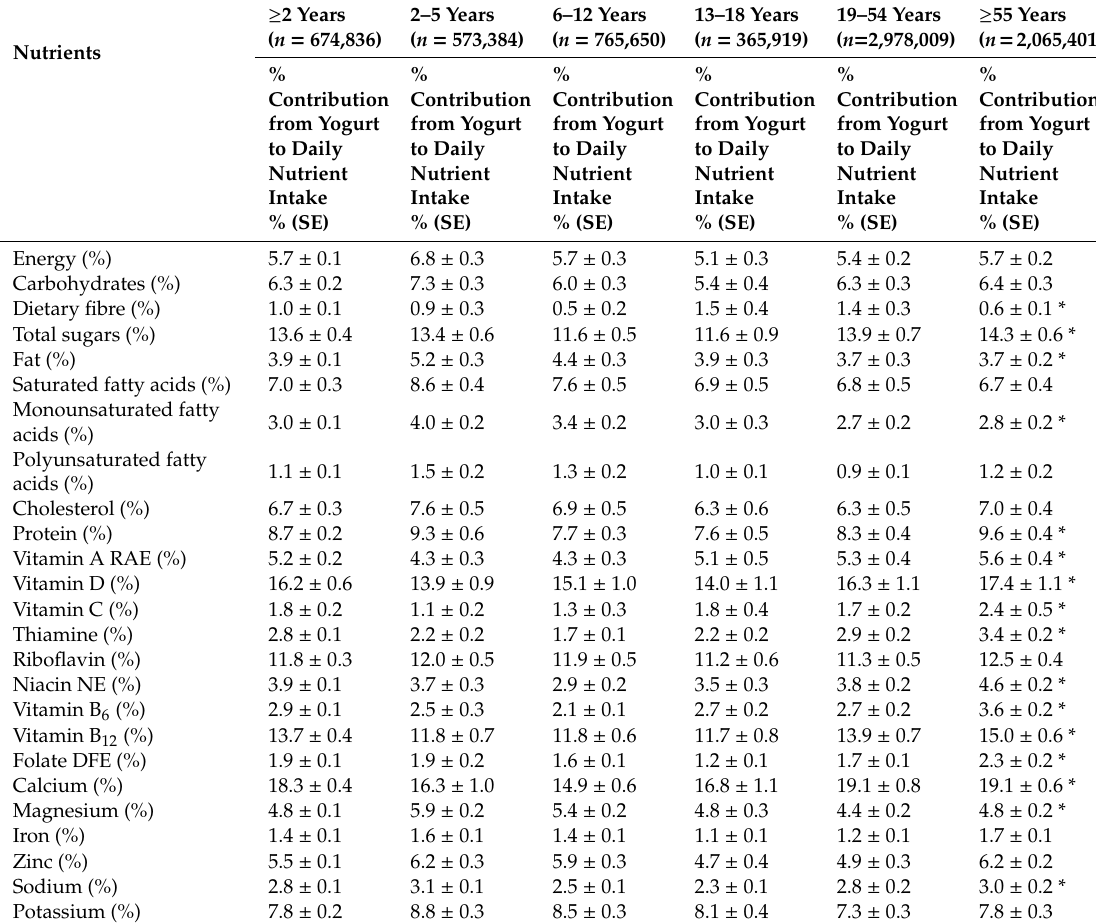
Table 4. Percent contribution from yogurt to daily energy and nutrient intake (yogurt consumers) 1